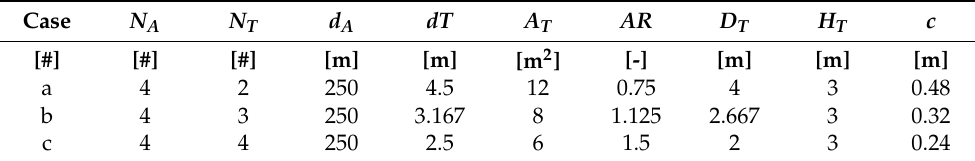
Table 1. Cases investigated with respect to array design. Nomenclature: N A number of arrays, N T number of turbines per array, d A array spacing, d T turbine spacing, A T turbine swept area, AR turbine aspect ratio, D T turbine diameter, H T turbine height, and c blade chord.